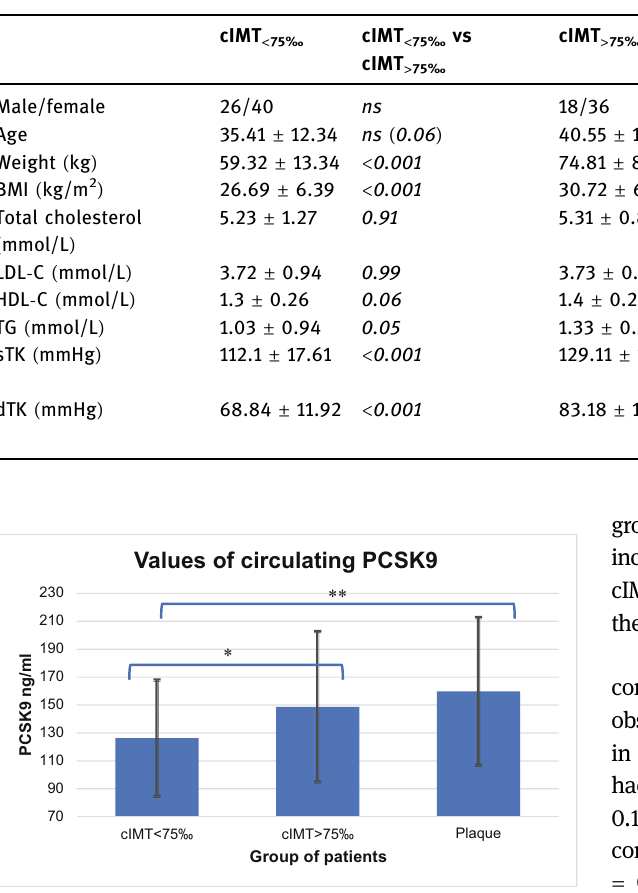
Figure 1: Values of circulating PCSK9 in di ff erent groups of patients according to the vascular changes ( * p < 0.05; ** p < 0.01; *** p < 0.001 ) .